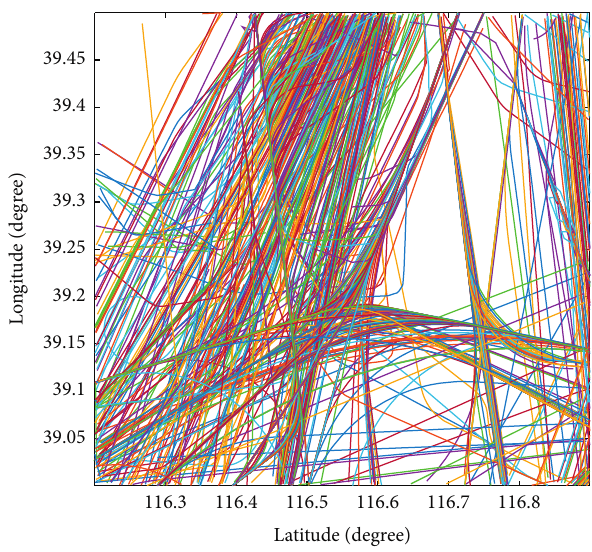
Figure 1: Original trajectory